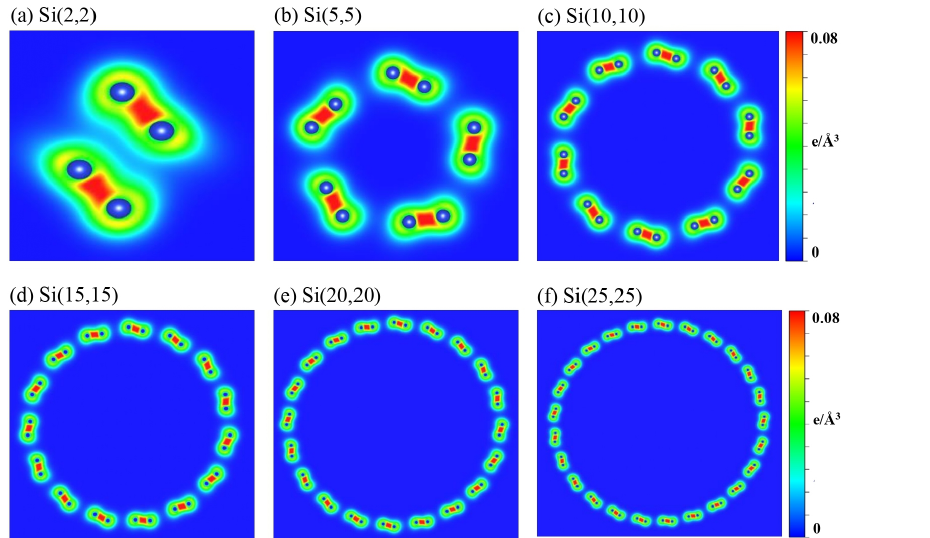
Figure 5. The spatial charge densities on the (x,z)-plane for aSiNTs with different chiral vectors: ( a ) (2,2), ( b ) (5,5), ( c ) (10,10), ( d ) (15,15), ( e ) (20,20), and ( f )